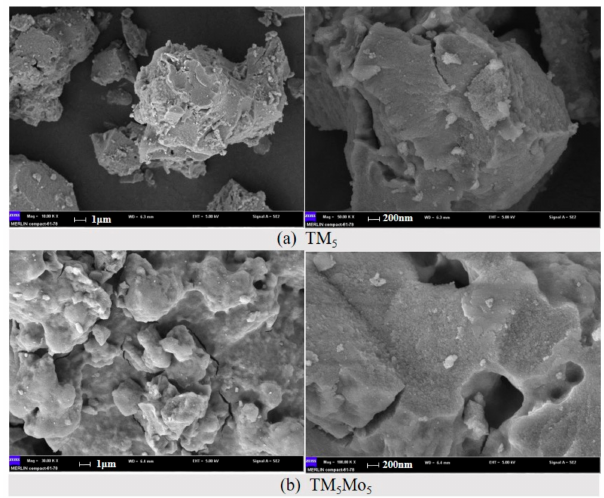
Figure 2. The scanning electron microscopy (SEM) images of ( a ) TM 5 and ( b ) TM 5 Mo